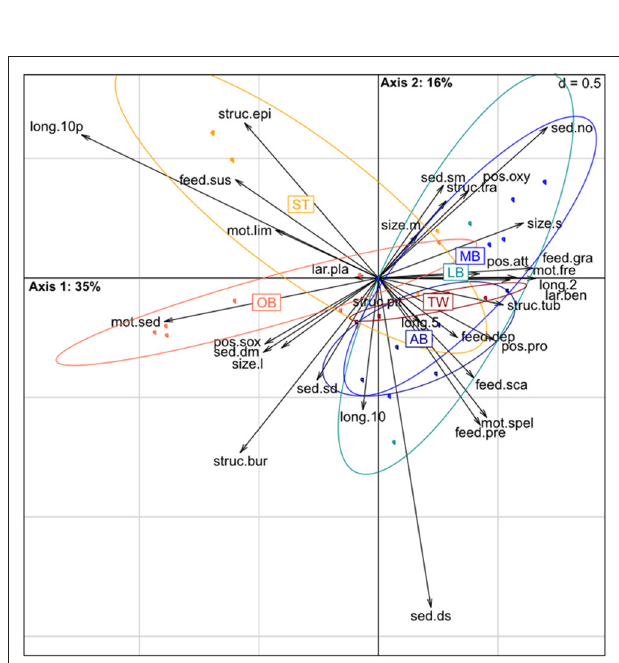
FIGURE 5 | Results of Fuzzy Correspondence Analysis on macrofauna data for pore-water (PW) cores. 2D ordination of samples based on trait categories exhibited by the communities (weighted by the untransformed biomass); samples (points) are grouped (circles) for stations, arrows point to the center of gravity of the samples presenting that category modality. Ellipses show the 95% confidence intervals. First axis explained 35% of total variation of the trait data, second axis − 16%. See Table 2 for traits